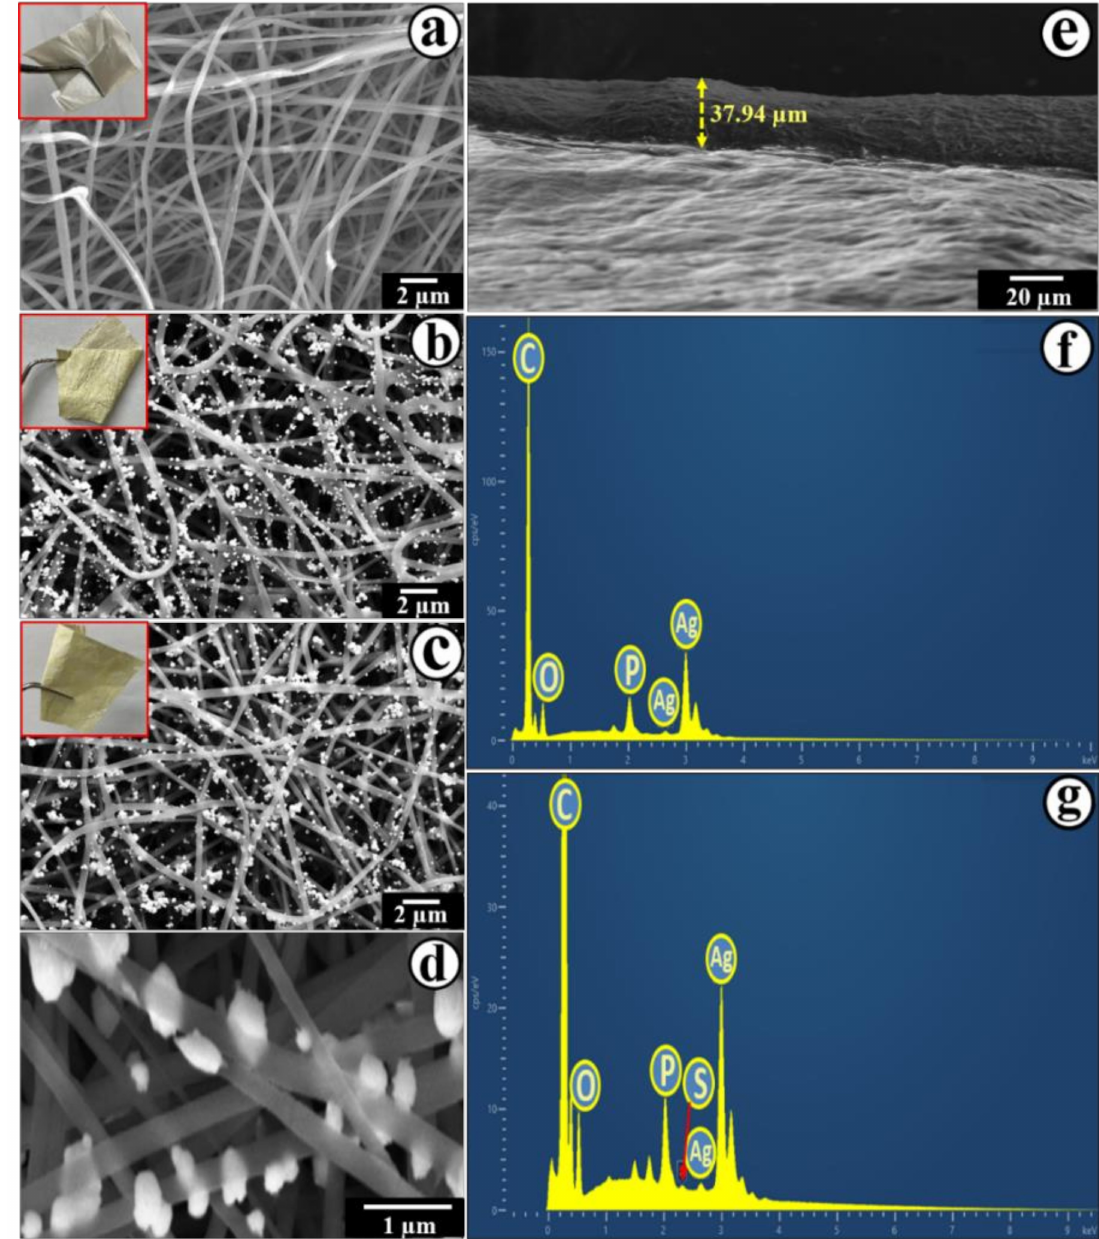
Figure 2. FESEM images; ( a ) Na 2 HPO 4 / PAN nanofibers, ( b ) AP / PAN, ( c ) S-AP / PAN, ( d ) high magnification image of S-AP / PAN and ( e ) cross section image of S-AP / PAN showing thickness of nanofibers mat. Panels ( f ) and ( g ) represent the corresponding EDS of ( b ) and ( c ), respectively. Insets; digital photograph of corresponding